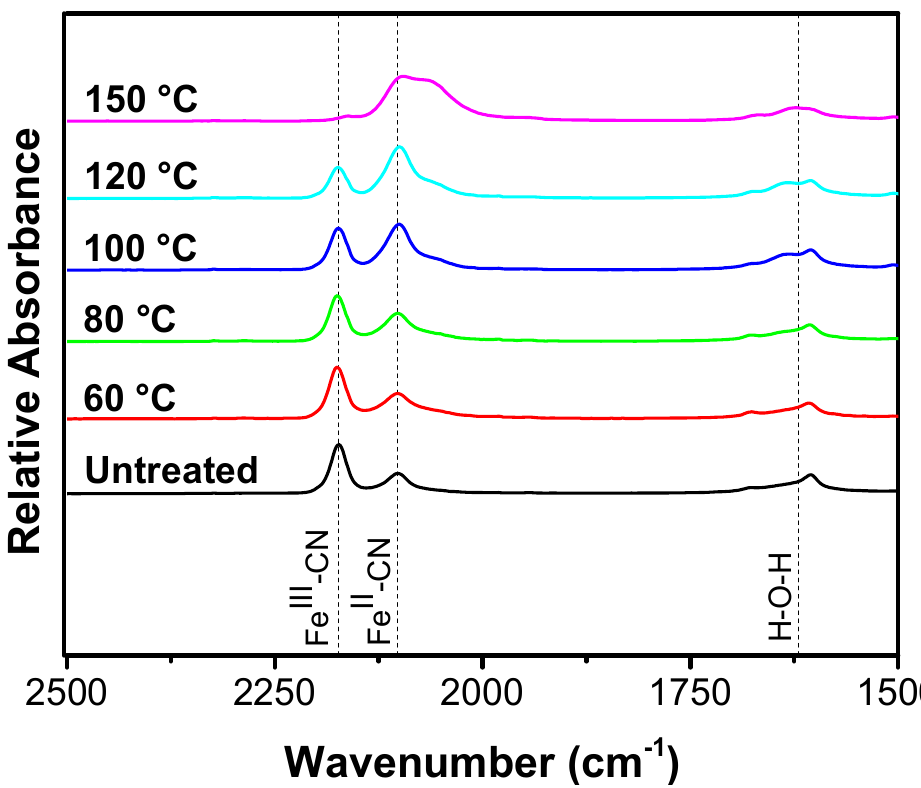
Figure 6. The ATR-FTIR spectra of the synthesized CuHCF powders thermally treated at different temperatures.